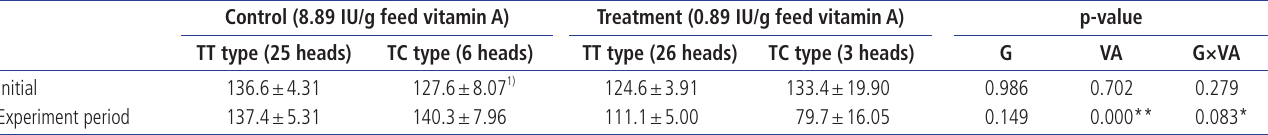
Table 2. Effect of ADH1C genotype on the level of serum vitamin A during vitamin A restriction (study 1)